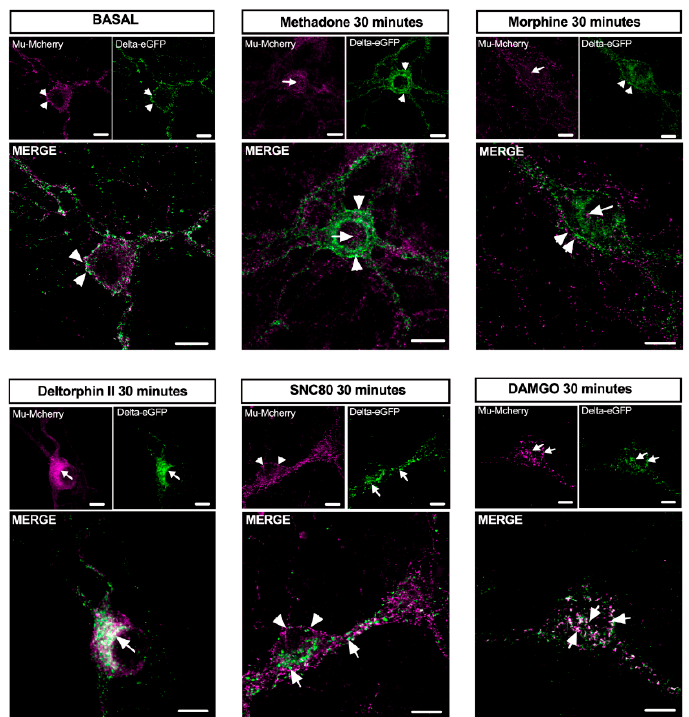
Figure 5. Mu–delta opioid receptor co-internalization is ligand-selective in primary hippocampal cultures. Representative confocal images showing mu-mCherry and delta-eGFP fluorescence at the plasma membrane (arrowheads) under basal conditions or co-internalized in vesicle-like structures (arrows) 30 min after DAMGO (1 μ M) or deltorphin II (100 nM), but not SNC80 (100 nM), morphine (10 μ M), or methadone (1 μ M). Scale bar = 10 μ m.